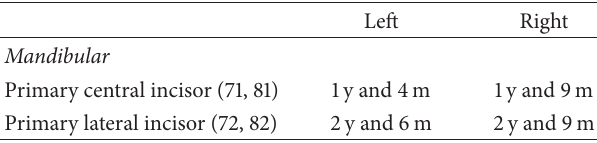
Table 1: Age at which teeth exfoliated spontaneously or were extracted because of the marked mobility in the present case. Four exfoliated anterior teeth were used as samples. Left